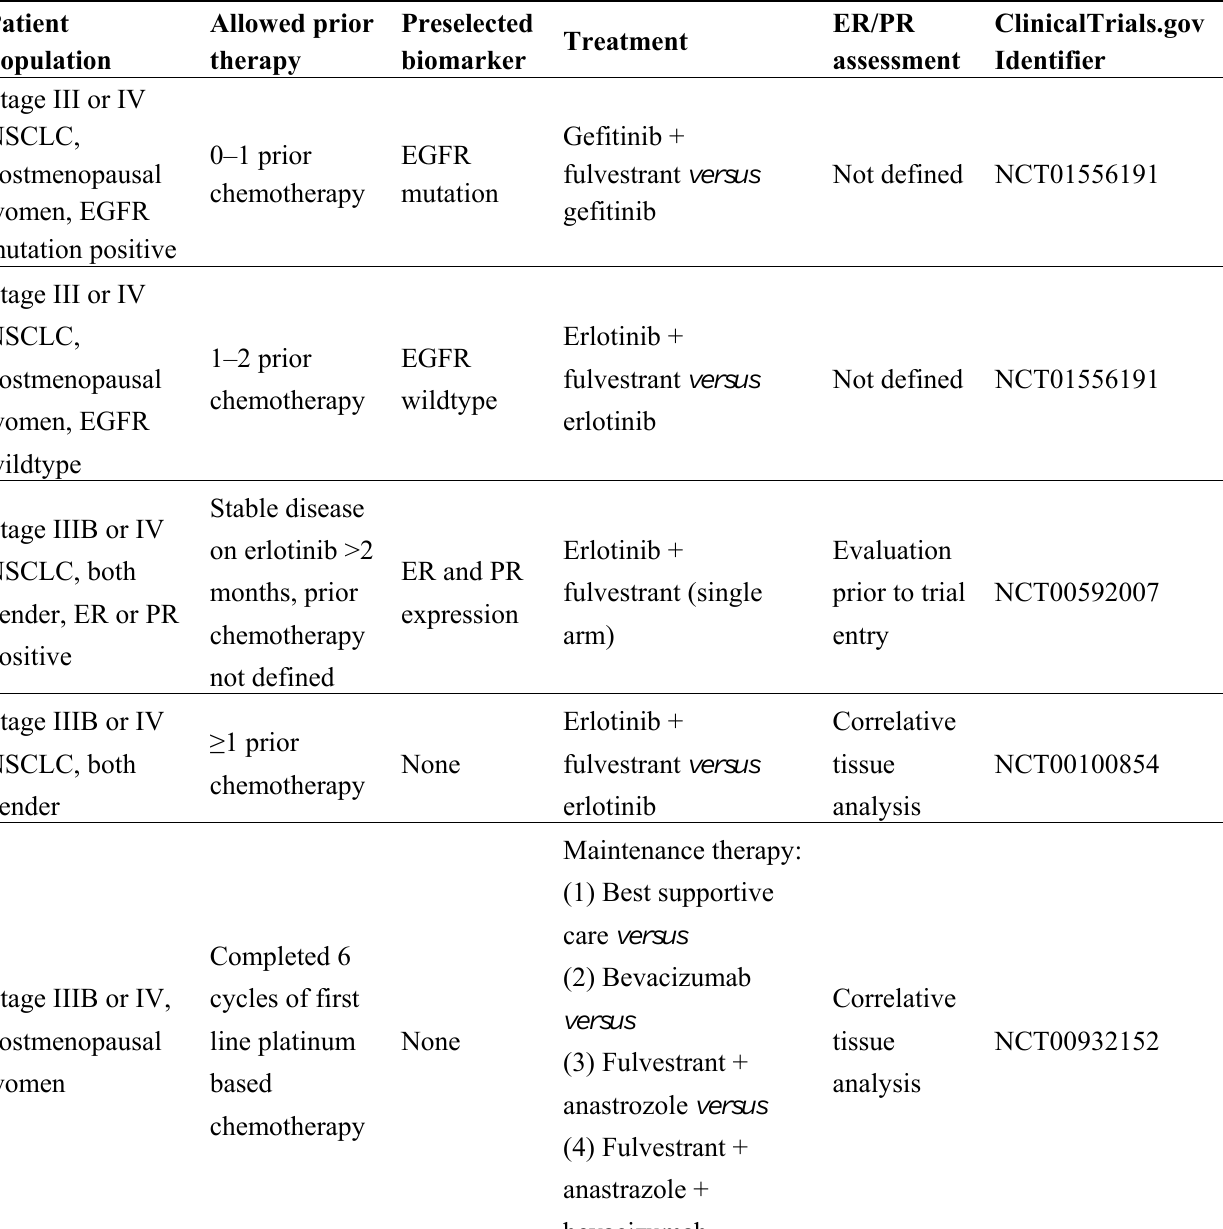
Table 4. Ongoing phase II clinical trials of hormonal therapy in advanced NSCLC